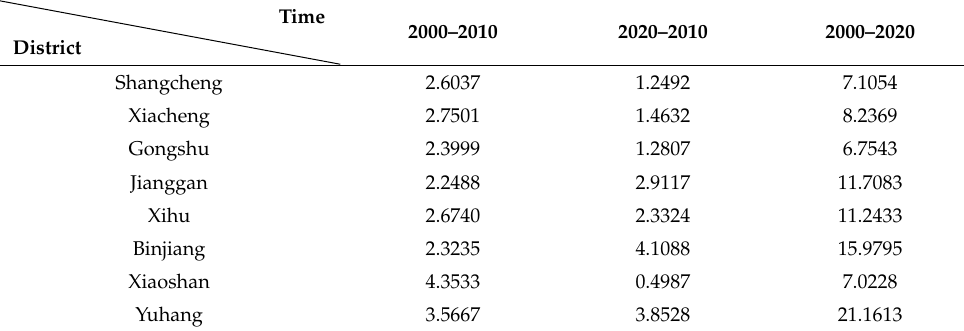
Table 3. The GDP change rate in Hangzhou at different time